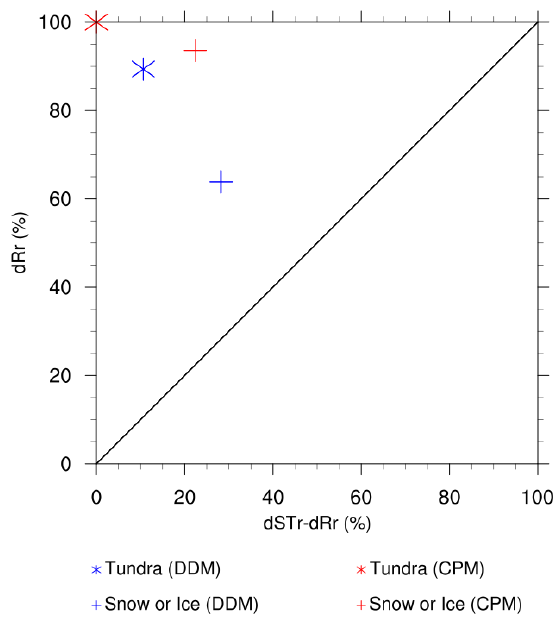
Figure 9. Relative contributions (normalized deviations between DDM (dynamical downscaling modeling) or CPM (convection-permitting modeling) and ERA-Interim) from surface net radiance deviation and land-surface processes deviation (unit: %) for tundra and snow or ice land-use categories in the non-monsoon season. The ordinate is the deviation from radiance; the abscissa is deviation from the land-surface processes. The black solid line indicates 1:1 correspondence of the first and third quadrants.